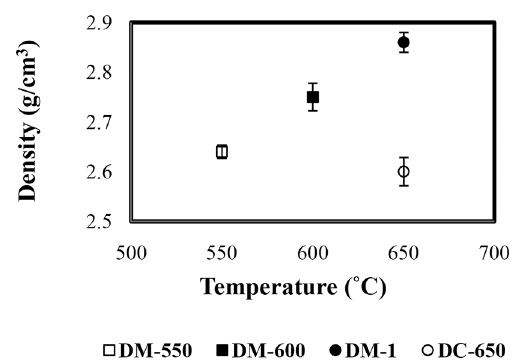
Figure 2: Density of Al composites sintered at temperatures 550˚, 600˚, and 650˚C using microwave heating and conventional furnace.